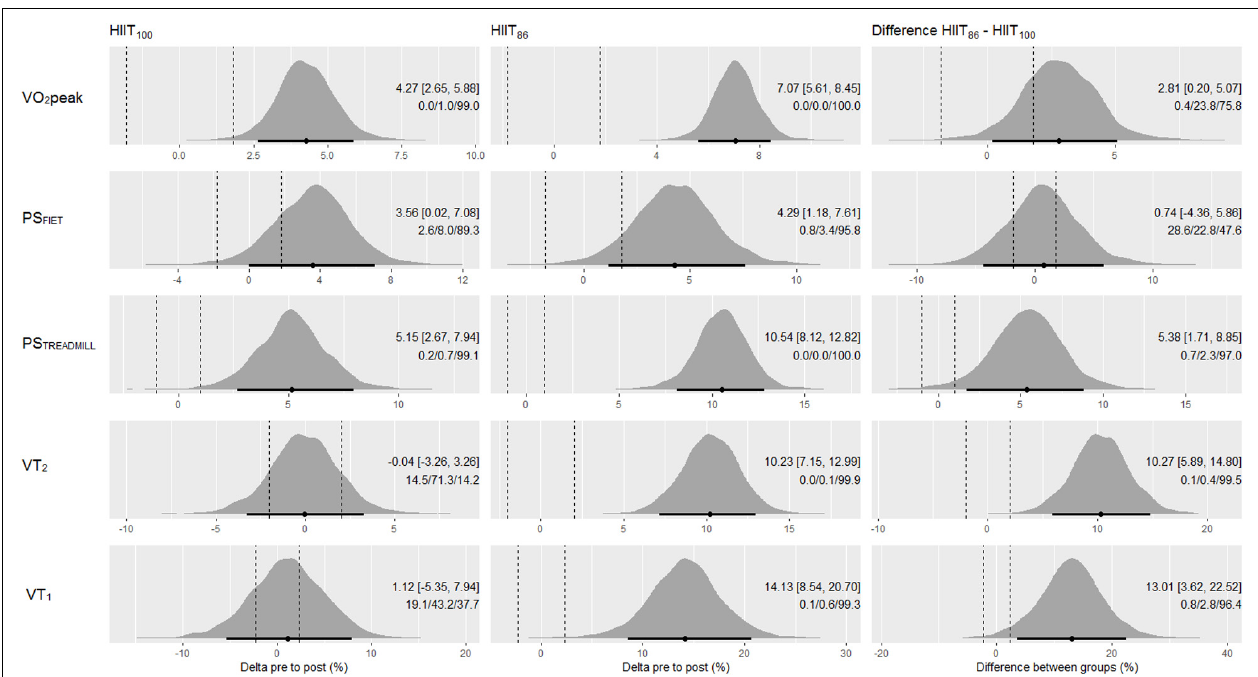
FIGURE 2 | Posterior density distributions and the respective means with 90% credible intervals of the pre to post changes in VO 2 peak, PS FIET , PS TREADMILL , VT 2 , and VT 1 (upper to lower panels, respectively) in each HIIT model, and the comparison of changes between models. The effects are adjusted to baseline mean of all study subjects. Black points and error bars are the posterior mean change and 90% credible intervals, respectively. Vertical dashed lines are the lower and upper boundaries of the ROPE (i.e., 0.2 × between subjects SD). The texts in each graph are the means (90% CI) and probabilities against